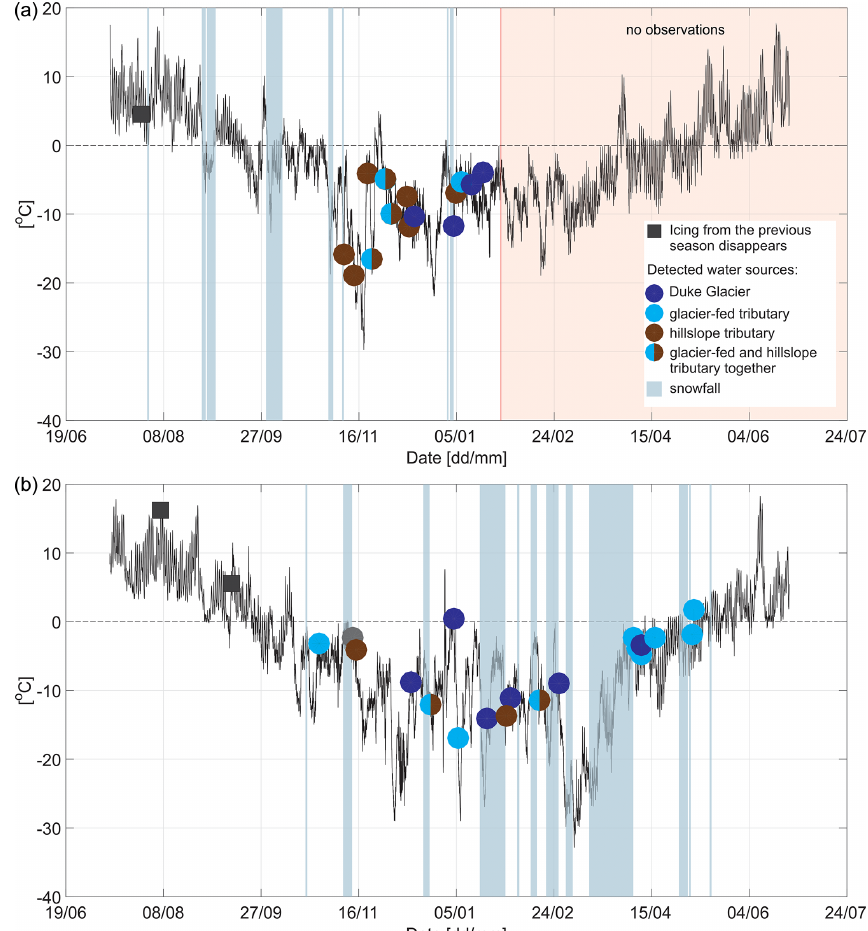
Figure 7. Hydrological activities observed in the Upper Duke watershed by the use of time-lapse cameras for the 2015–2016 season (a) and the 2016–2017 season (b) . Solid black lines show air temperature measured at the automatic weather station. Circles represent the timing of hydrological activity related to different water sources. The coloured circles identify a specific source type. In cases where different sources were observed as being active on the same day, the circle has multiple